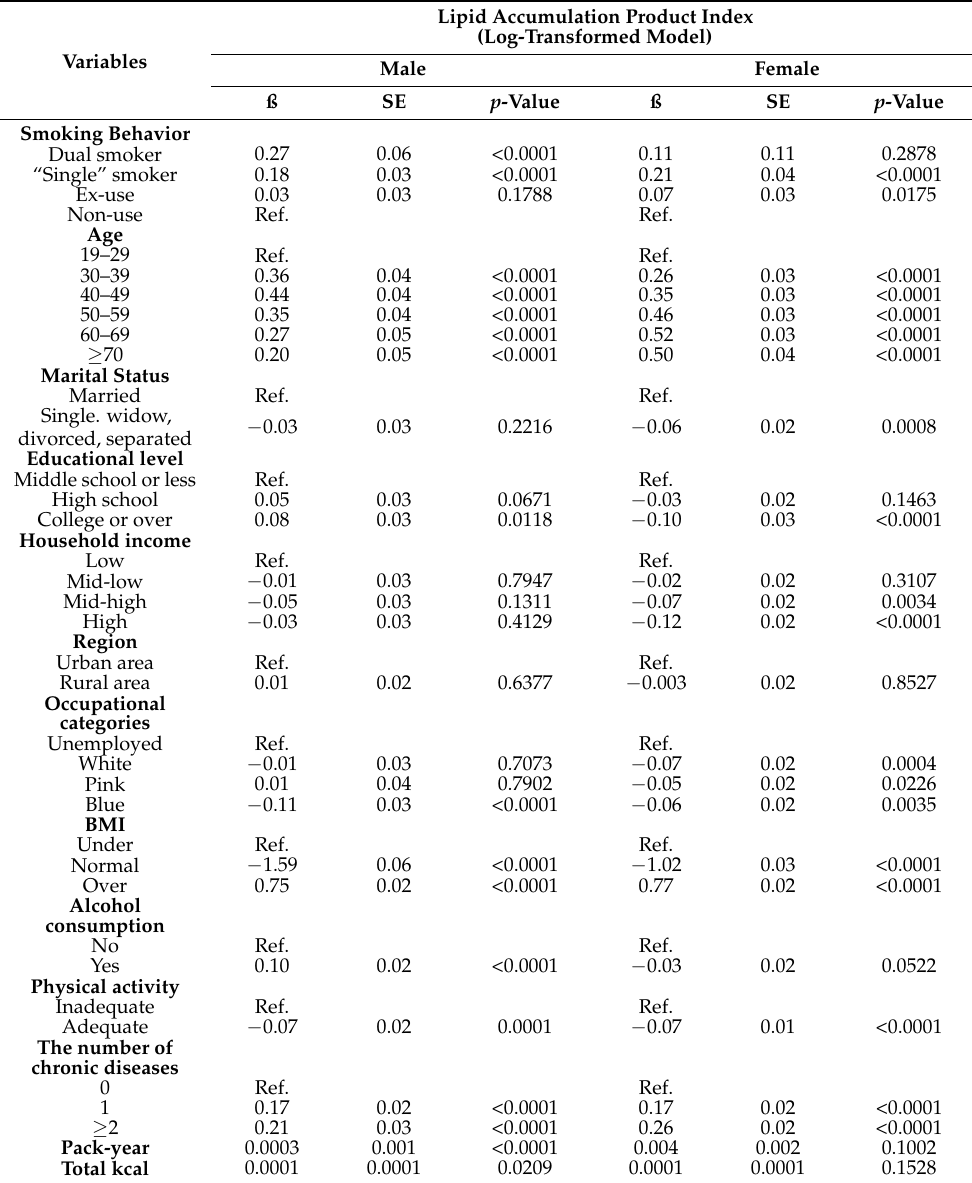
Table 2. Association between Smoking Behavior and Log-transformed Lipid Accumulation Product index.